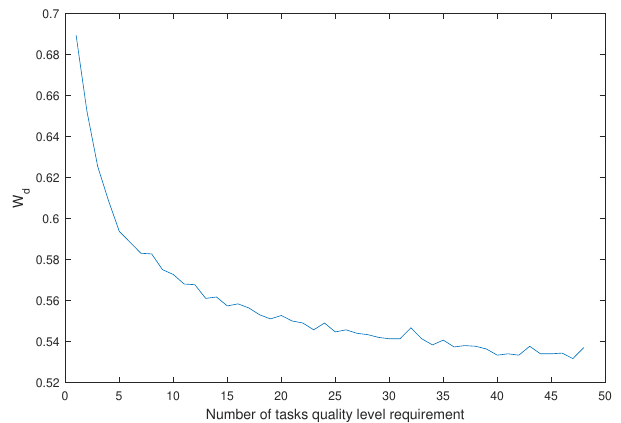
Figure 5. Effect of increasing the number of robots’ quality levels on the weight W d .